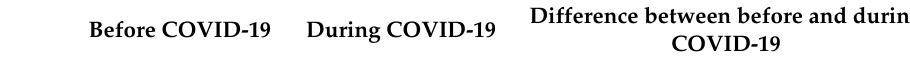
Table 3. The proportion of individuals that responded with “often” or “very often” to the questions: “What was your reason to visit nature areas before resp. during the COVID-19 pandemic?”.